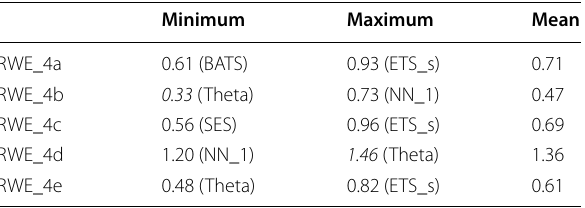
Table 15 Minimum, maximum and mean values of the MdoAE within the experiments using the StandTempDat